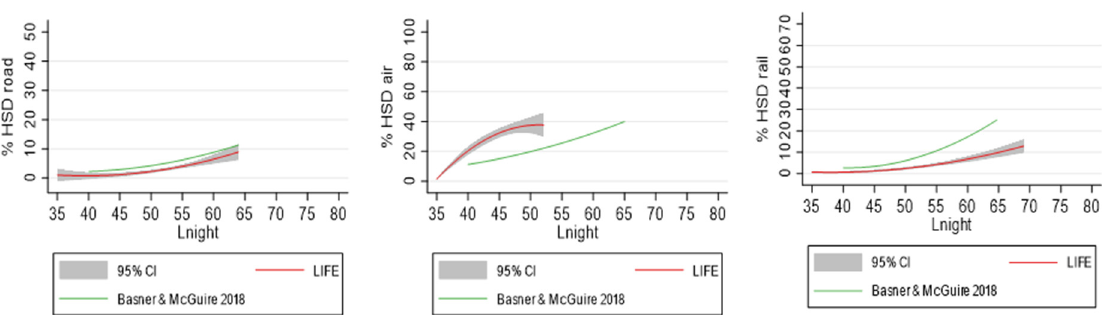
Figure 1. Comparison of HSD risk curves for road traffic, rail traffic and aircraft noise between the LIFE study and the WHO (Basner and McGuire 2018 [14]).